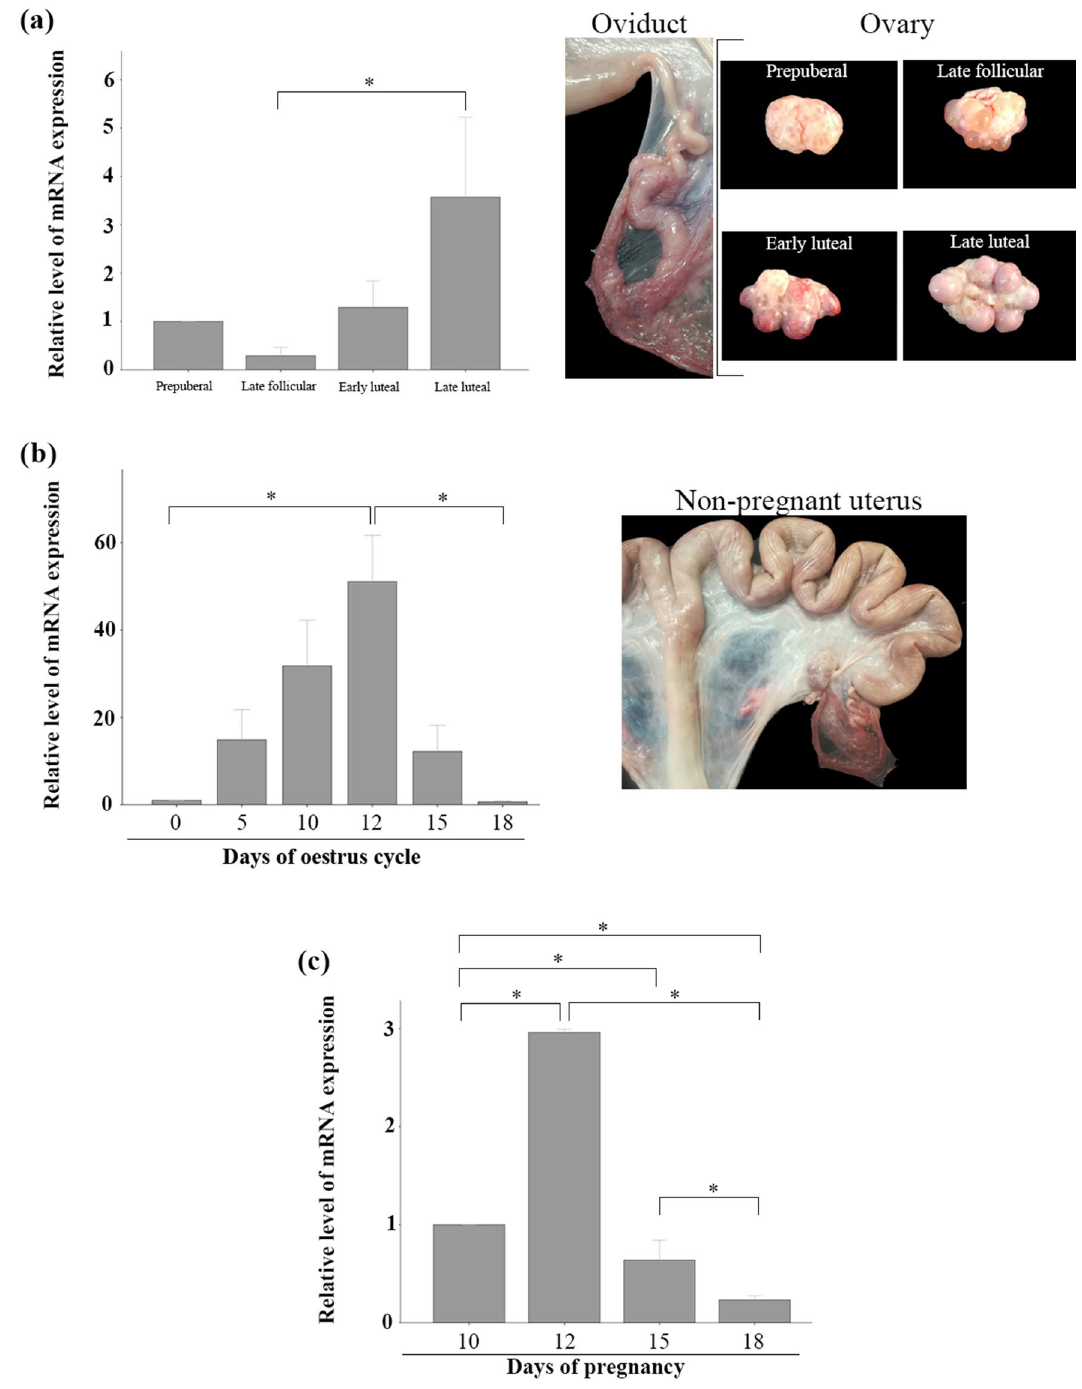
Figure 1. (a) Relative level of mRNA expression of haptoglobin in the oviduct in different phases of the porcine oestrus cycle. (*) Between experimental groups indicates significant differences (p = 0.07). (b) Relative level of mRNA expression of haptoglobin in endometrium of cyclic sows. Day 0 indicates the ovulation point. (*) Between experimental groups indicates significant differences (p < 0.05). (c) Relative level of mRNA expression of haptoglobin in endometrium of pregnant sows. (*) between experimental groups indicates significant differences (p < 0.05). Data are shown as mean ±